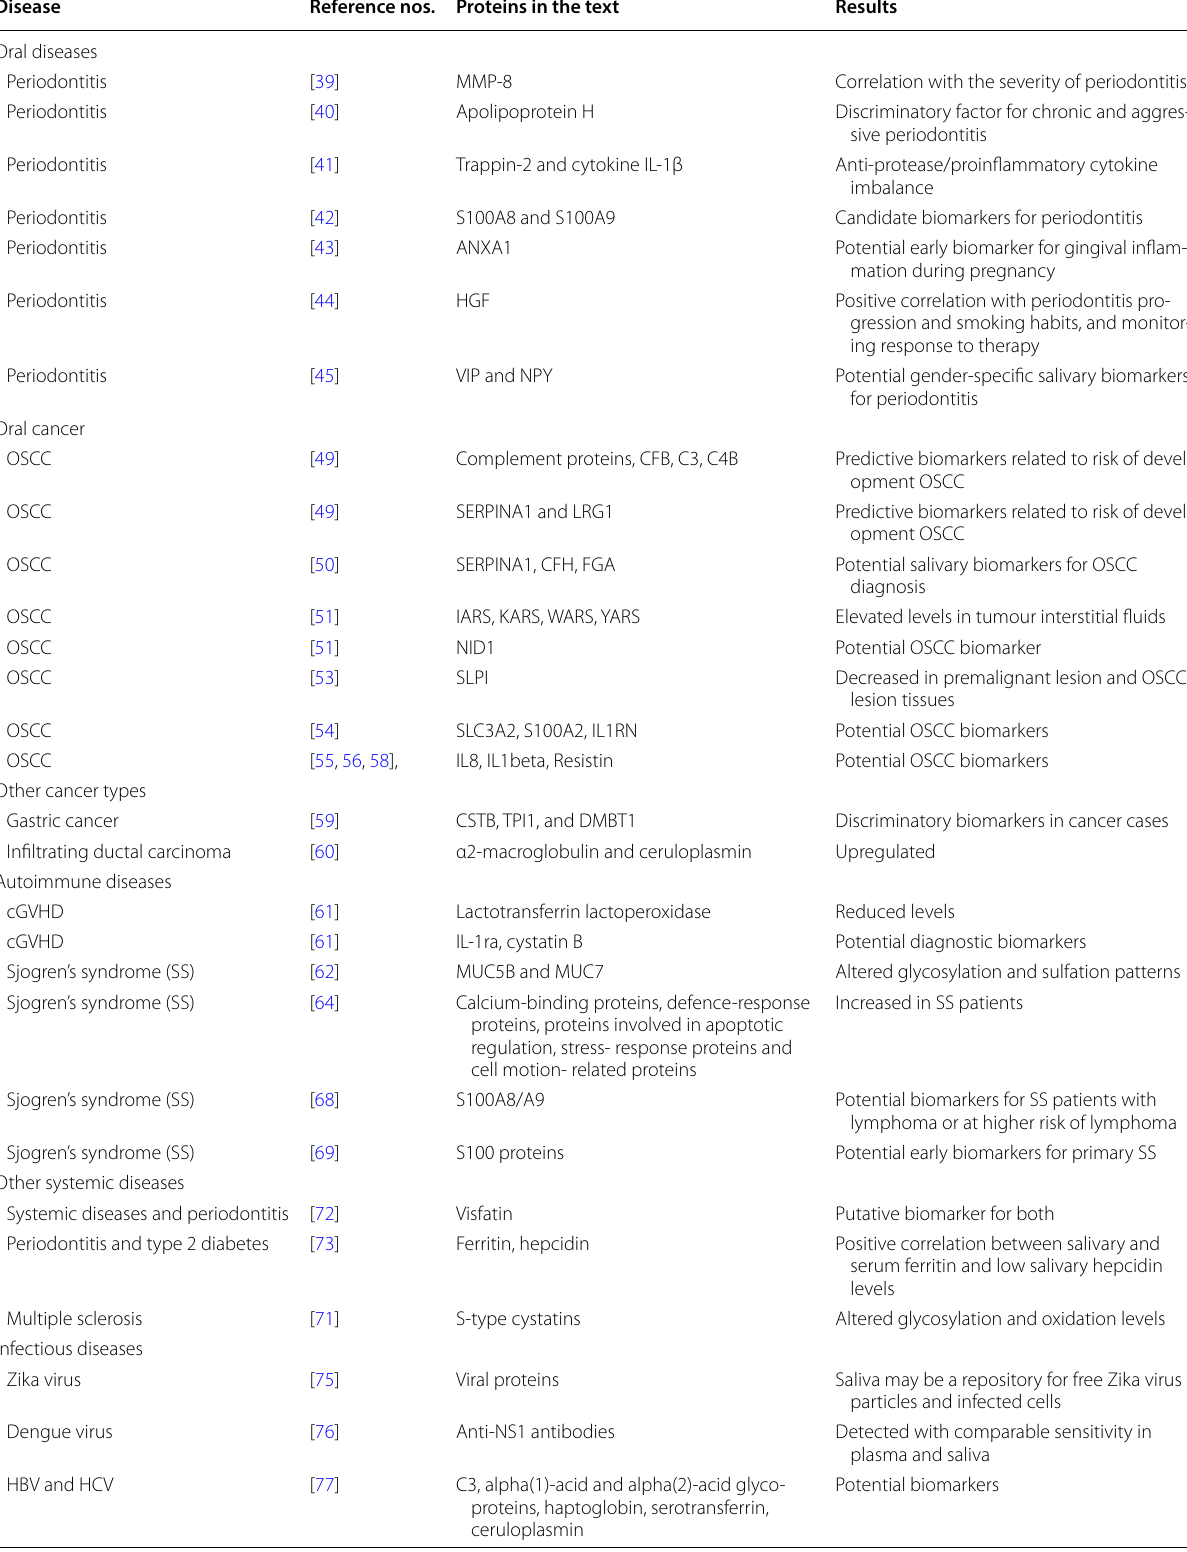
Table 1 An outline of the prospective clinical applications of salivary proteomics in a large spectrum of human diseases Disease Reference nos. Proteins in the